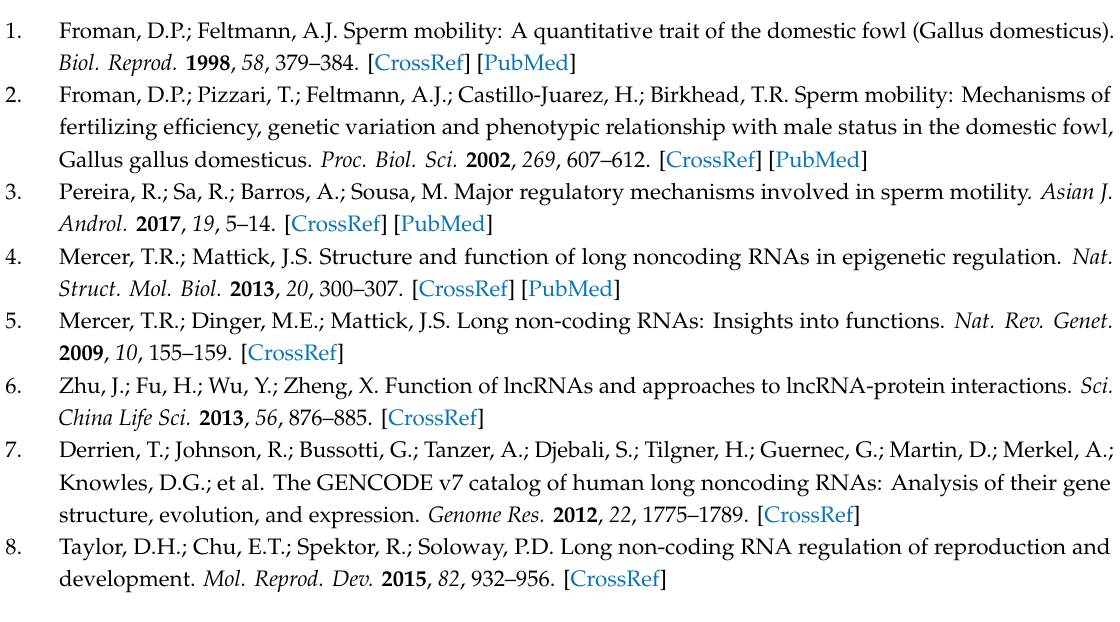
Table S1: Primers of lncRNAs and mRNAs used in qPCR. Table S2: Quality control of the sequencing data. Table S3: The information for the identified lncRNAs. Table S4: GO terms analysis of di ff erentially mRNAs expression. Table S5: KEGG pathways analysis of di ff erentially mRNAs expression. Table S6: GO terms analysis of di ff erentially lncRNAs expression. Table S7: KEGG pathways analysis of di ff erentially lncRNAs expression. Author Contributions: H.M. and H.L. designed the experiments; X.X., Y.T., H.M. and H.L. contributed to sample collection; X.X. and Y.T. performed experiments; X.X. analyzed the data and drafted the manuscript; Y.T., H.M., H.L., X.D. and Z.Y. reviewed and edited the manuscript. All authors read and approved the final